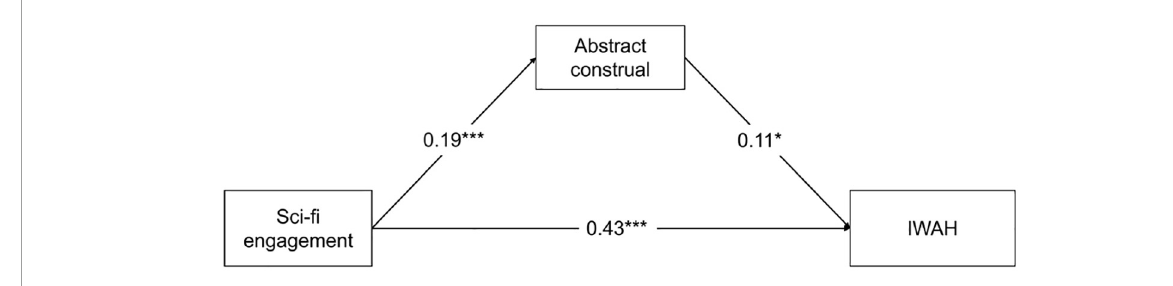
FIGURE2 Results of the mediation analysis. *** p < 0.001, * p < 0.05; IWAH, Identification with all humanity.